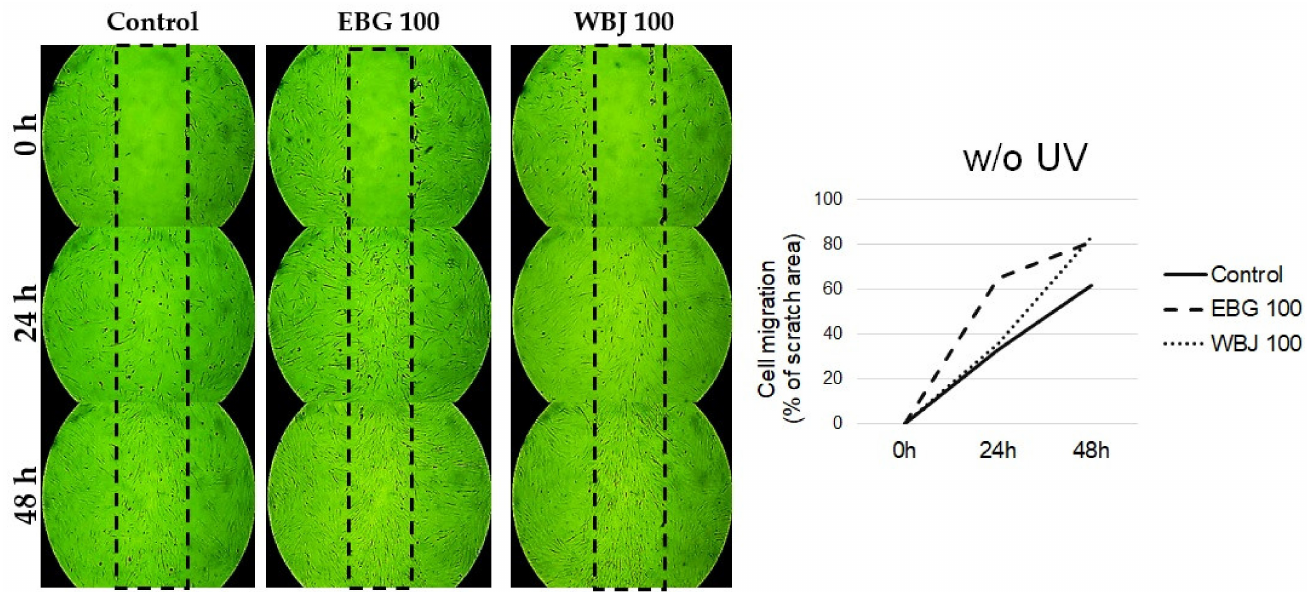
Figure 11. Effect of 70% ethanolic extract of barley grass (EBG) and 100 µ g/mL water extract of young barley juice (WBJ) on the migration of NHSF cell line without UV radiation.